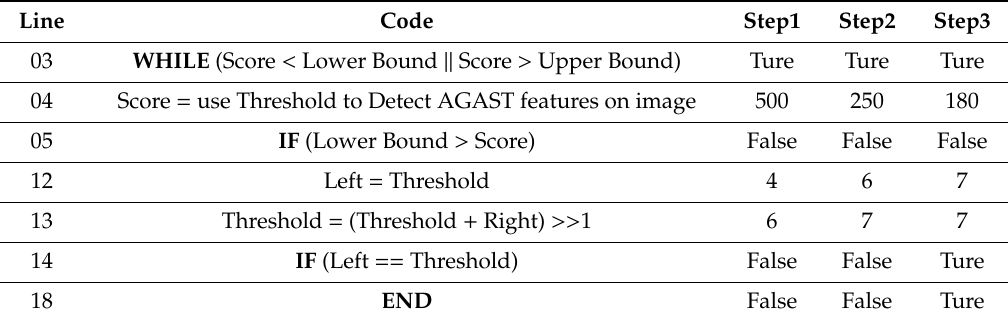
Table 1. Illustration of the MAGAST feature detection.